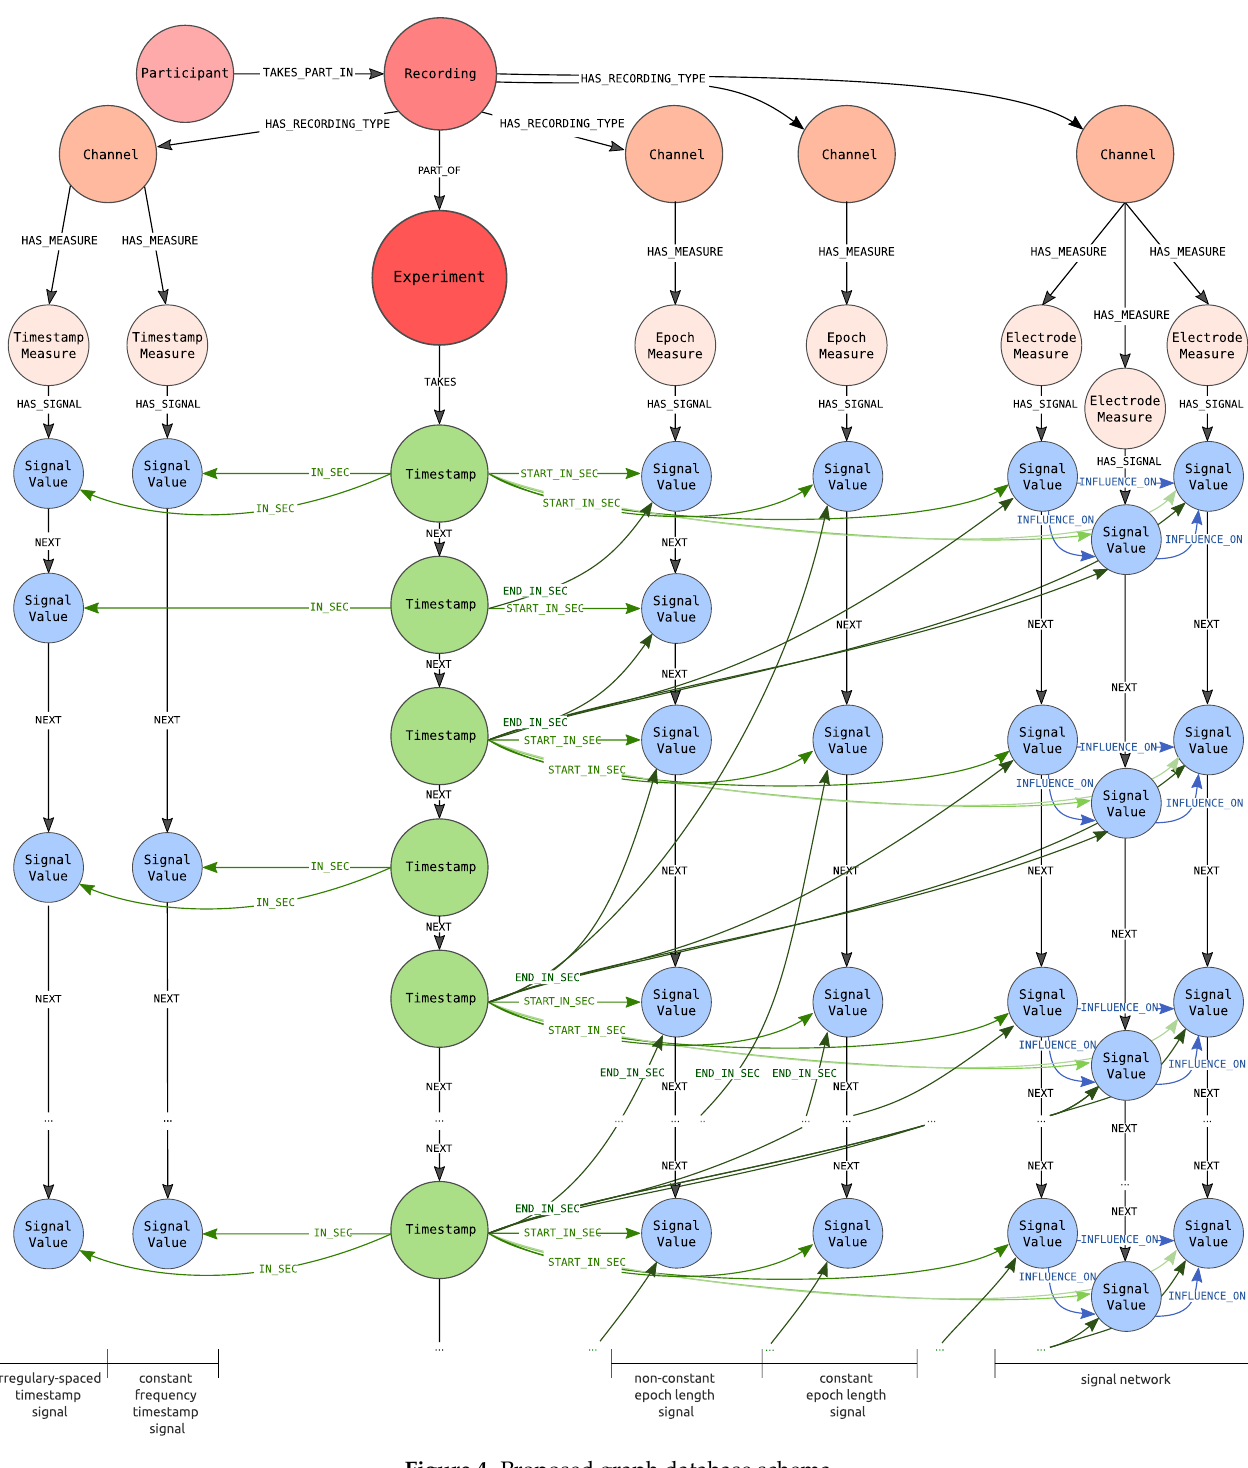
Figure 4. Proposed graph database